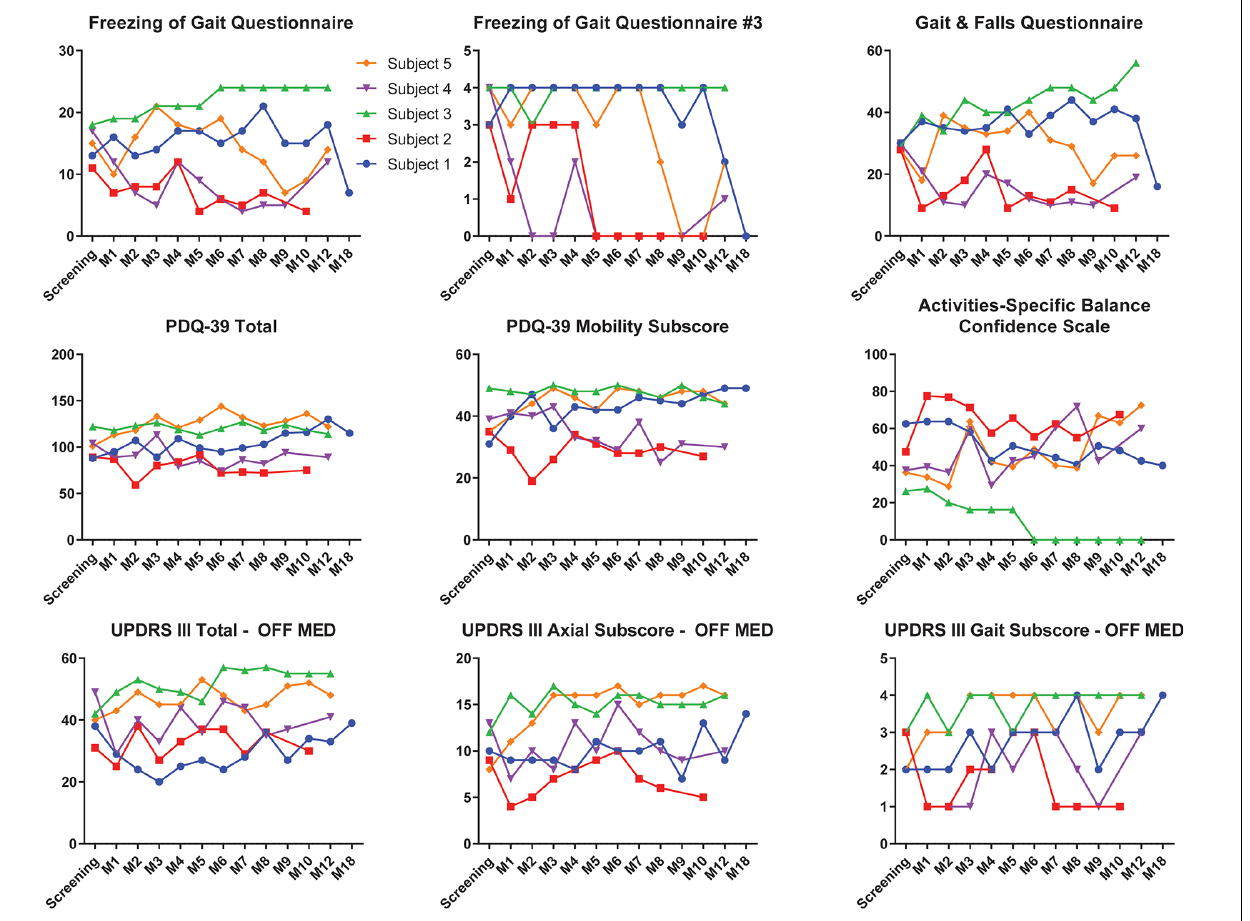
FIGURE 5 | Clinical outcome scores of each individual subject pre-deep brain stimulation (DBS) until the last available follow-up. Individual outcomes for each individual subject on the Freezing of Gait Questionnaire (FOGQ), FOGQ#3, Gait and Falls Questionnaire (GFQ), PD Quality of Life Questionnaire—3 (PDQ-39) total, PDQ-39 mobility, Activities-Specific Balance Confidence Scale (ABC), Unified PD Rating Scale III (UPDRS-III) off dopaminergic medication, UPDRS-III axial subscore (items 18, 27–30) off medication, and UPDRS-III gait subscore (item 29) off medication. Subjects 1 and 5 were on long-term pedunculopontine nucleus (PPN) closed-loop DBS (CL-DBS) during their 18- and 9- to 12-month visits, respectively. All other subjects did not have their PPN DBS activated. GPi open-loop DBS (OL-DBS) was activated during all